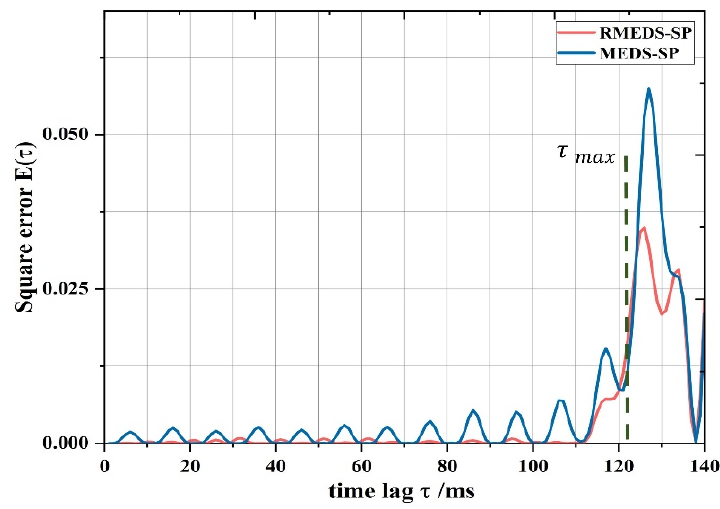
Figure 7. The error of ACF between the MEDS-SP and RMEDS-SP